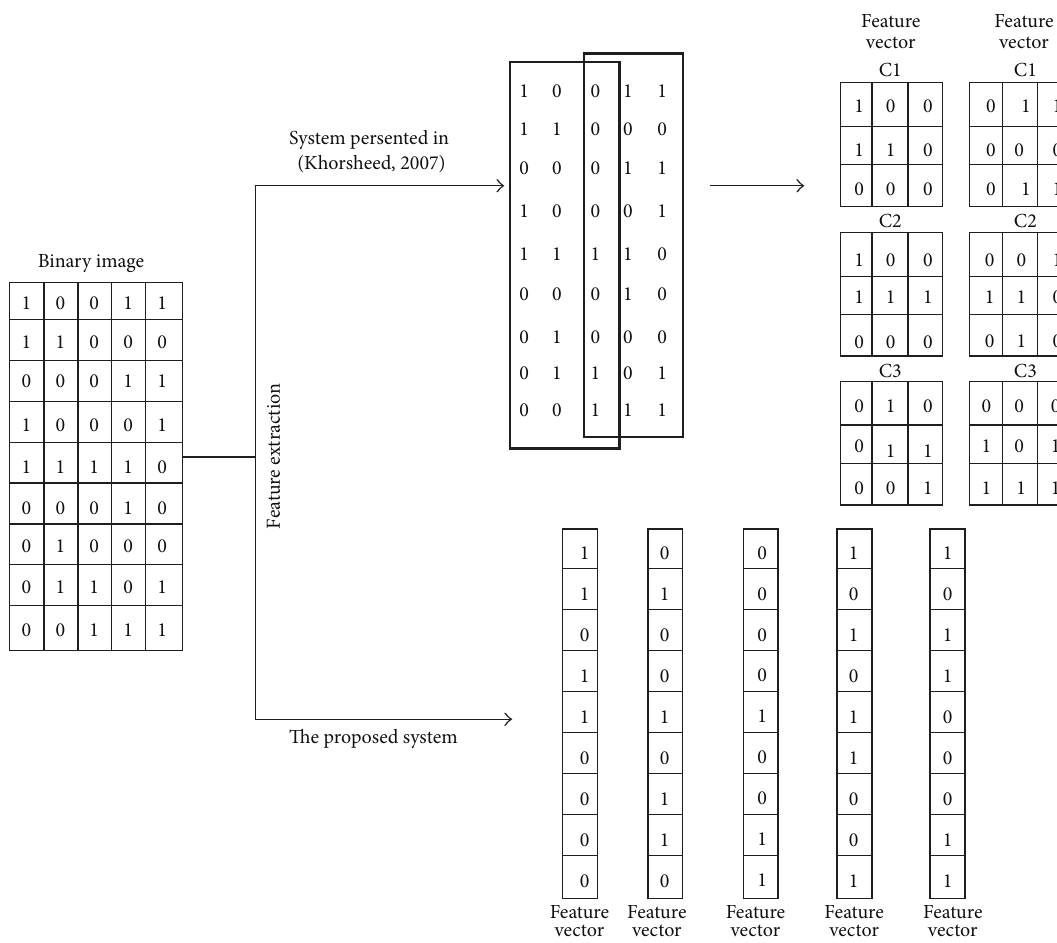
Figure 5: Feature extraction using the proposed algorithm and Khorsheed [7].